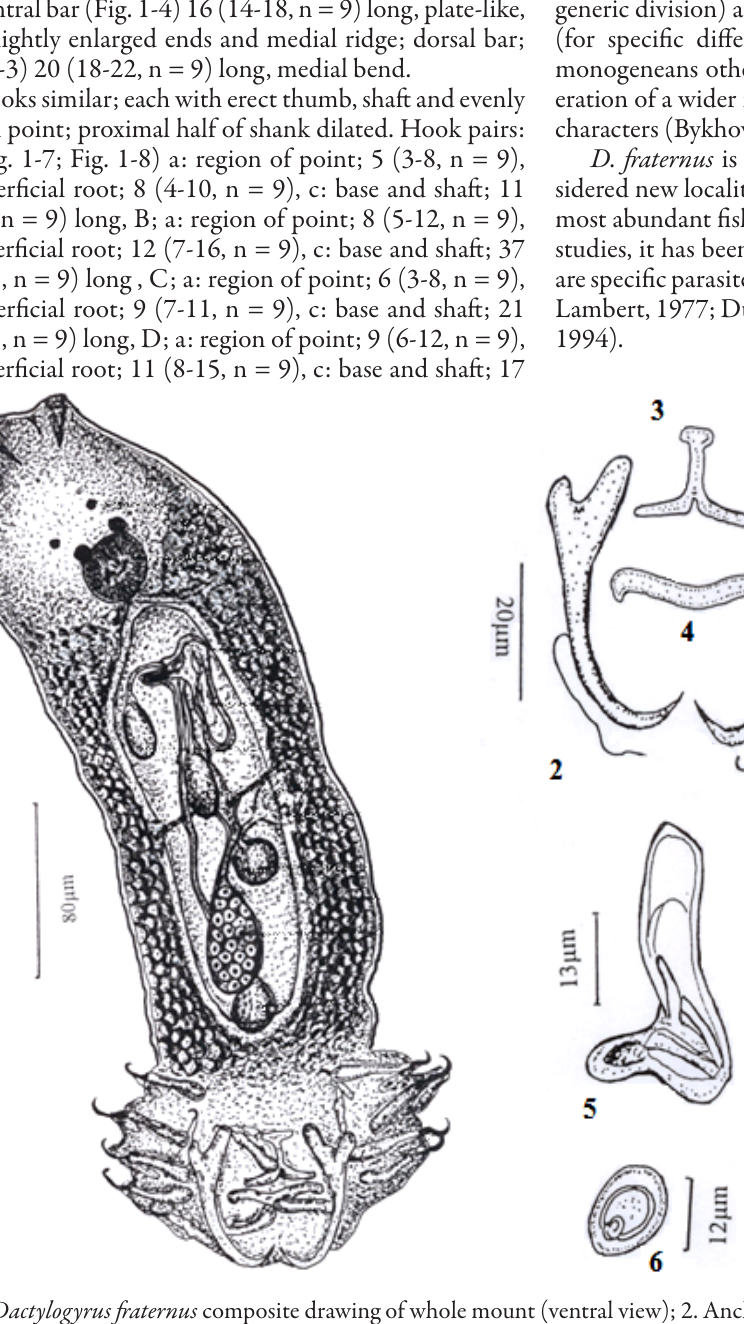
Fig. 1. Dactylogyrus fraternus composite drawing of whole mount (ventral view); 2. Anchors; 3. Dorsal bar; 4. Ventral bar; 5. Copu- latoty organ; 6. Vagina; 7. A - B -C - D marginal hook pairs; 7. a: region of point, b: superficial root, c: base and shaft; 8. Marginal hook scale (2-8 drawn to